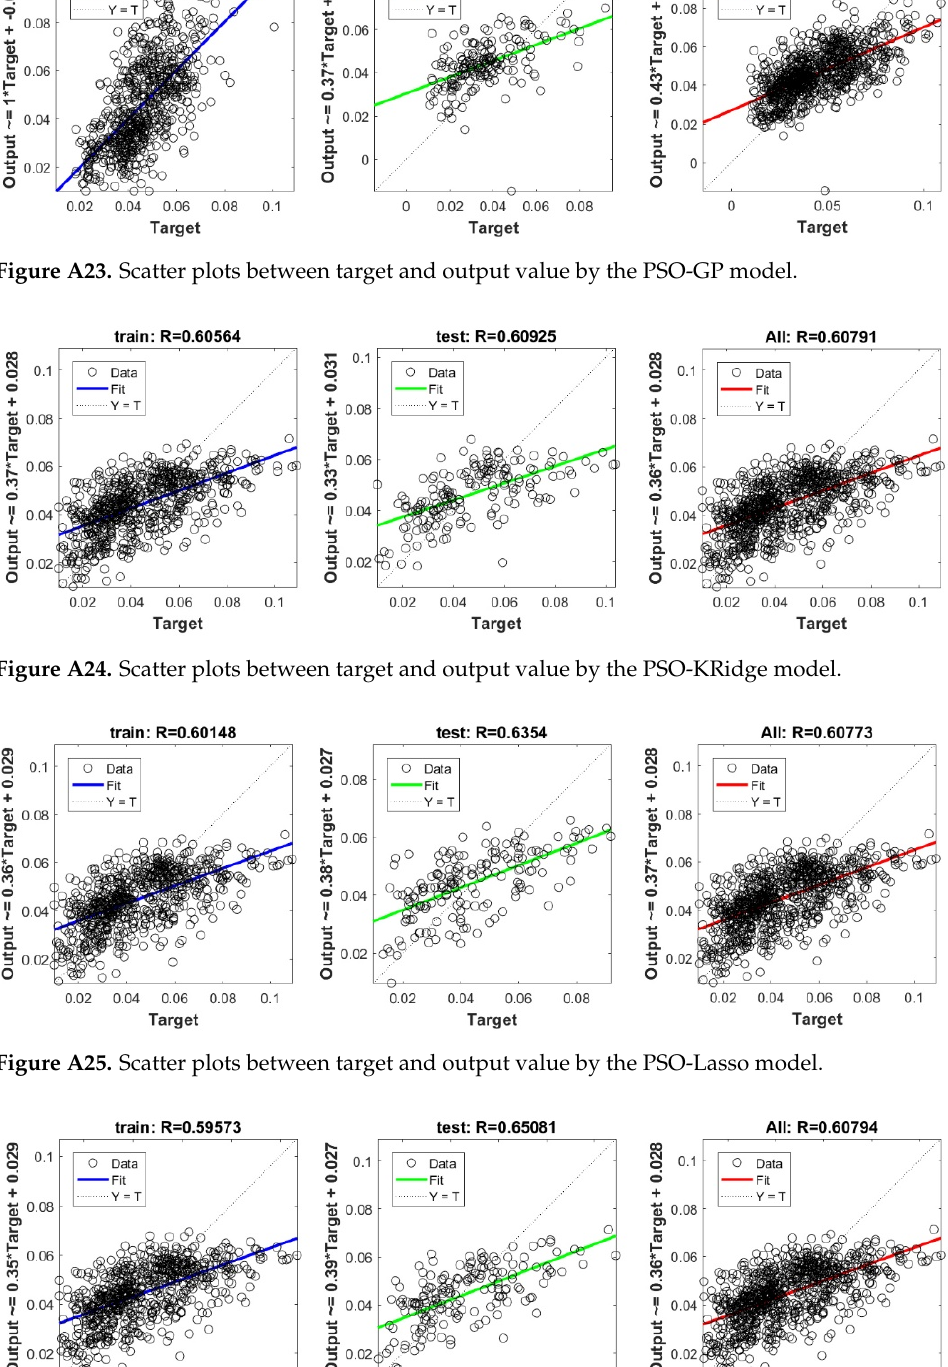
Figure A26. Scatter plots between target and output value by the PSO-PLS